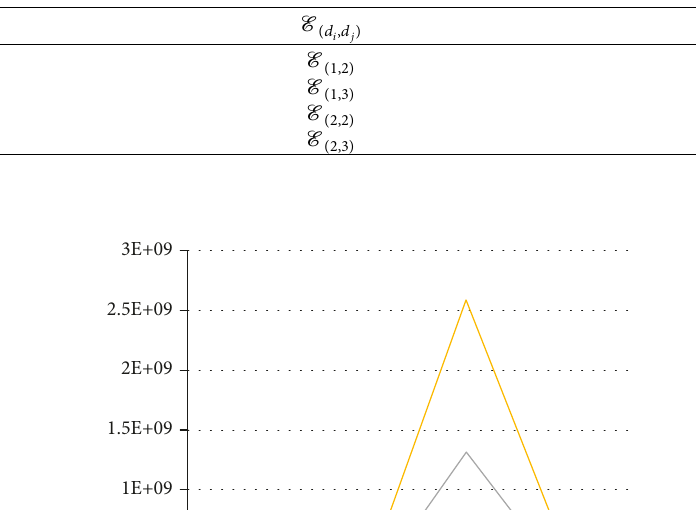
Figure 12: Poly (EThyleneAmidoAmine) (PETAA) dendrimer. Table 6: Edge partitioning based on degree of PETAA.